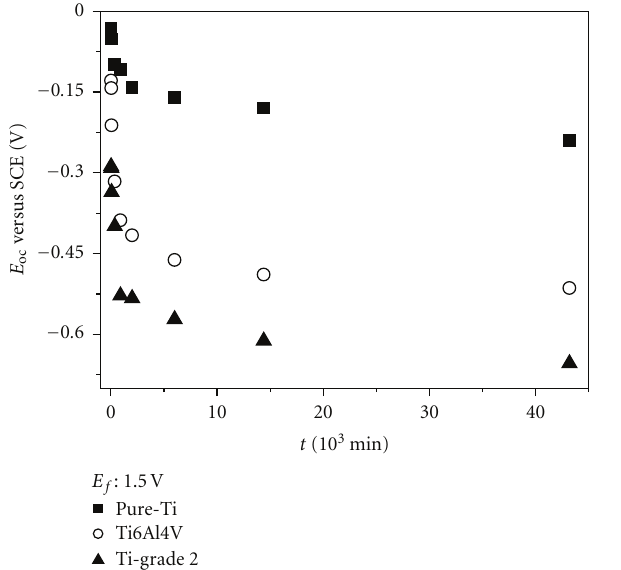
Figure 4: Oxide film reconstruction rate (RR%) as a function of immersion time, in saliva artificial, for Ti pure, Ti6Al4V alloy, and Ti-grade 2 electrodes covered with oxide films potentiodynamically grown up to 1.5V, in PBS